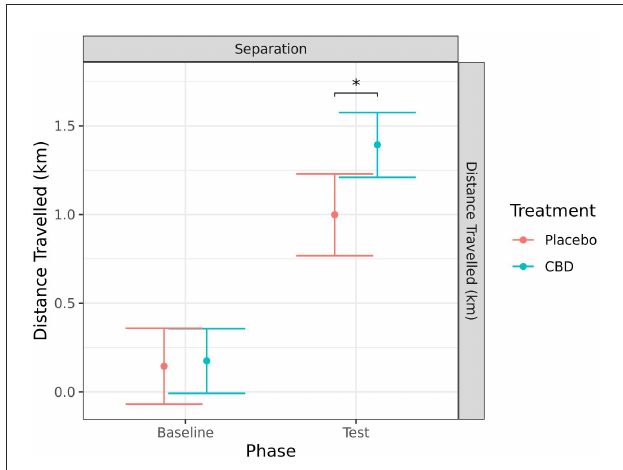
FIGURE10 Predicted mean (95% CI) distance traveled (km) generated by the Polar ® device for dogs given CBD or placebo at each phase of testing (baseline and test) during the separation test. Asterisks indicate significant differences between treatment groups within each phase. * p <